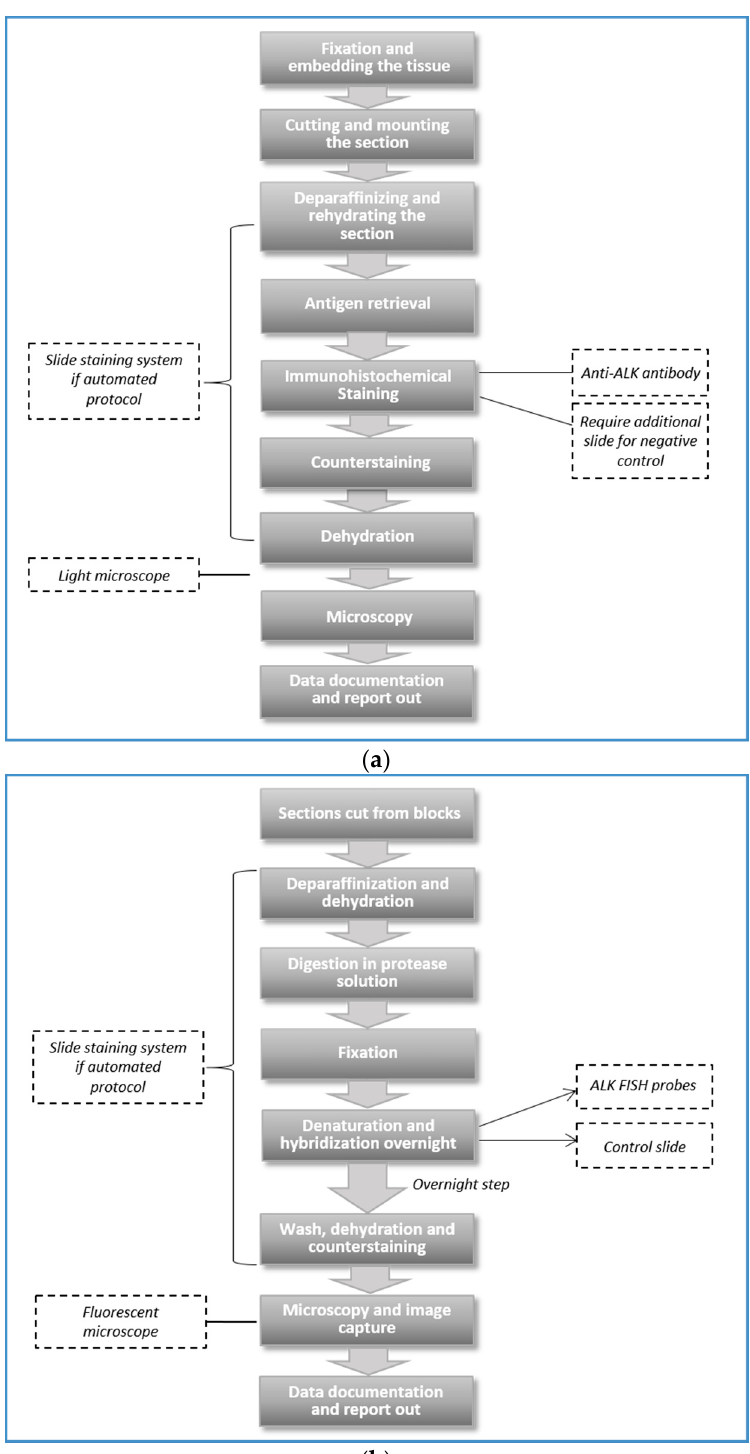
Figure 2. Key steps in the protocol of ( a ) IHC and ( b ) FISH methodologies.